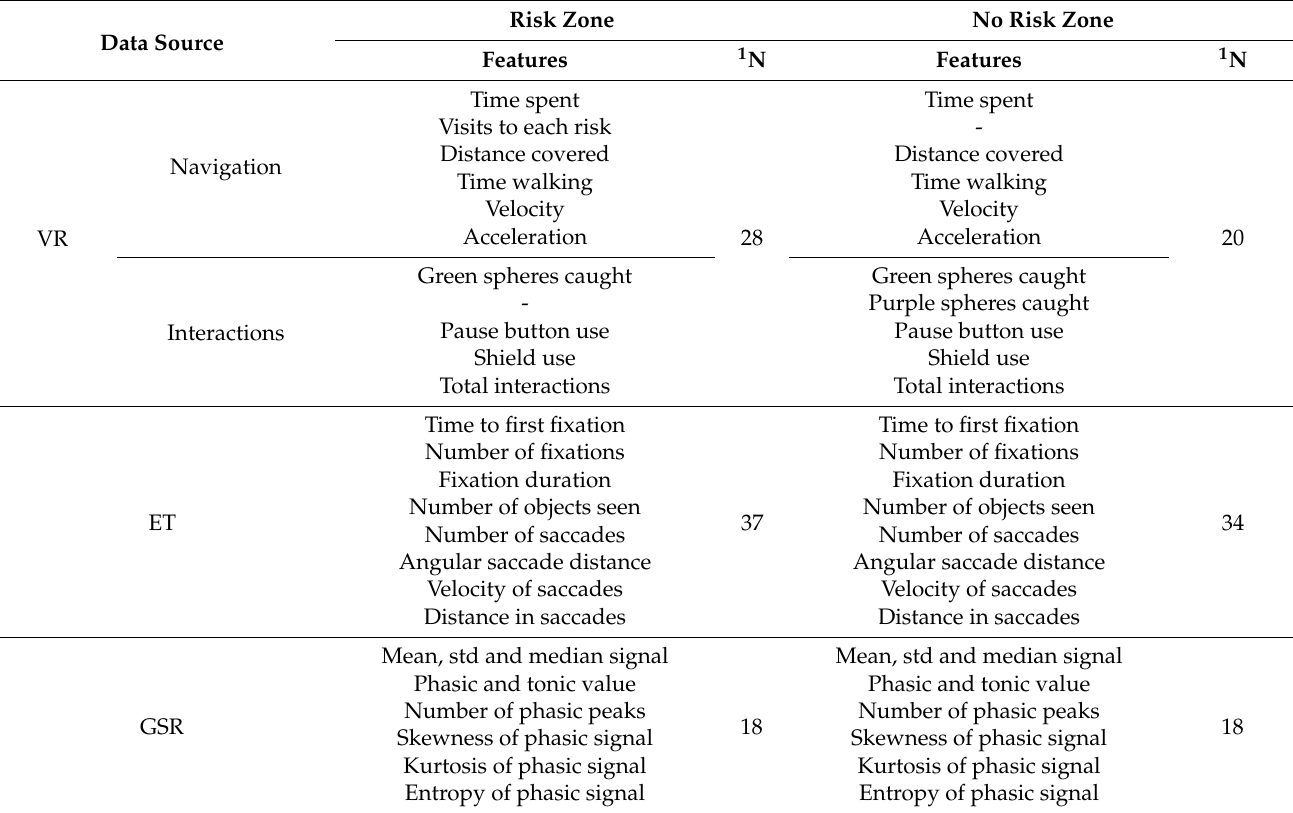
Table 2. Description of the set of features obtained by data